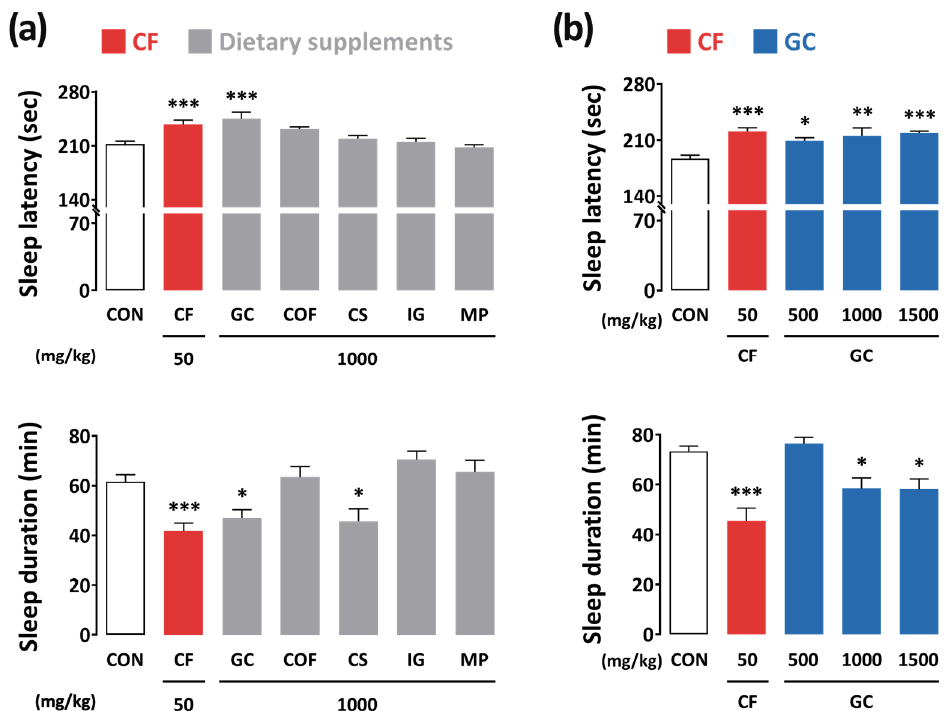
Figure 3. ( a ) Effects of dietary supplements on sleep latency and sleep duration in ICR mice treated with a hypnotic dose (45 mg/kg, i.p.) of pentobarbital. ( b ) Effects of GC and caffeine on sleep latency and sleep duration in ICR mice. The mice received pentobarbital injection 45 min after the oral administration (p.o.) of samples. Each column represents the mean ± SEM ( n = 10). * p < 0.05, ** p < 0.01, *** p < 0.001, significant difference as compared to the control group (Dunnett’s test). CON, control; CF, caffeine; GC, G. cambogia peel extract; COF, C. forskohlii extract; CS, C. sinensis L. extract; IG, I. gabonensis extract; MP, M. pumila Mill. extract; SEM, standard error of mean.